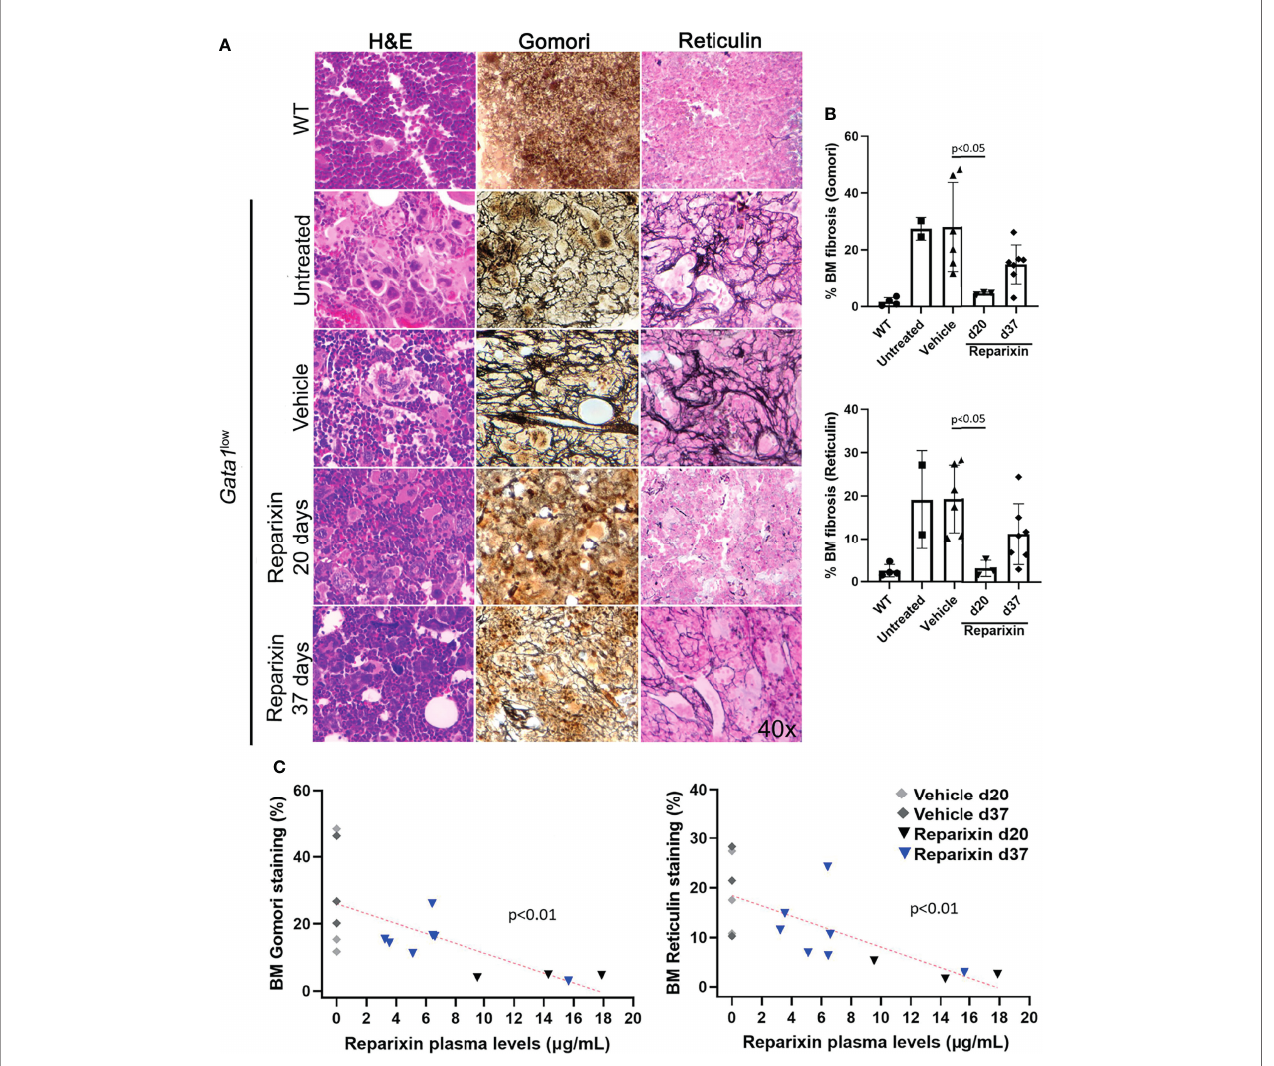
FIGURE 4 | Reparixin decreases in a concentration-dependent fashion the fi brosis present in the BM from Gata1 low mice. (A) H&E, Reticulin, and Gomori staining of BM sections from representative Gata1 low mice treated either with vehicle or Reparixin for 20 or 37 days, as indicated. Untreated Gata1 low and WT littermates are presented as positive and negative controls, respectively. Magni fi cation ×400. (B) Levels of fi brosis quanti fi ed by computer image analyses on BM sections stained with Gomori or Reticulin from multiple Gata1 low mice treated either with vehicle or Reparixin, as indicated. Data are presented as Mean (± SD) and are analyzed by Tukey ’ s multiple comparisons test. P < 0.05 was considered statistically signi fi cant. (C) Linear regression analyses between fi brosis plasma concentration or Reparixin in individual mice (Pearson R = − 0.66, p < 0.01 for Gomori staining; Pearson R = − 0.71, p < 0.01 for Reticulin staining). Each dot represents an individual